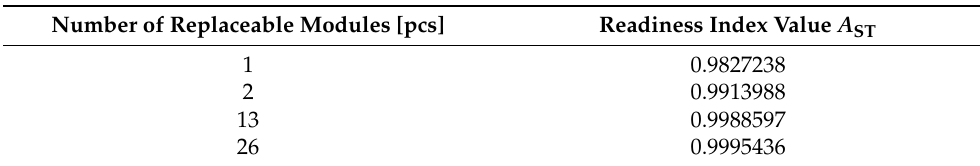
Table 2. List of the number of replaceable modules at a toll collection station for the determination of its readiness index appropriate value. Source: own study based on [14].